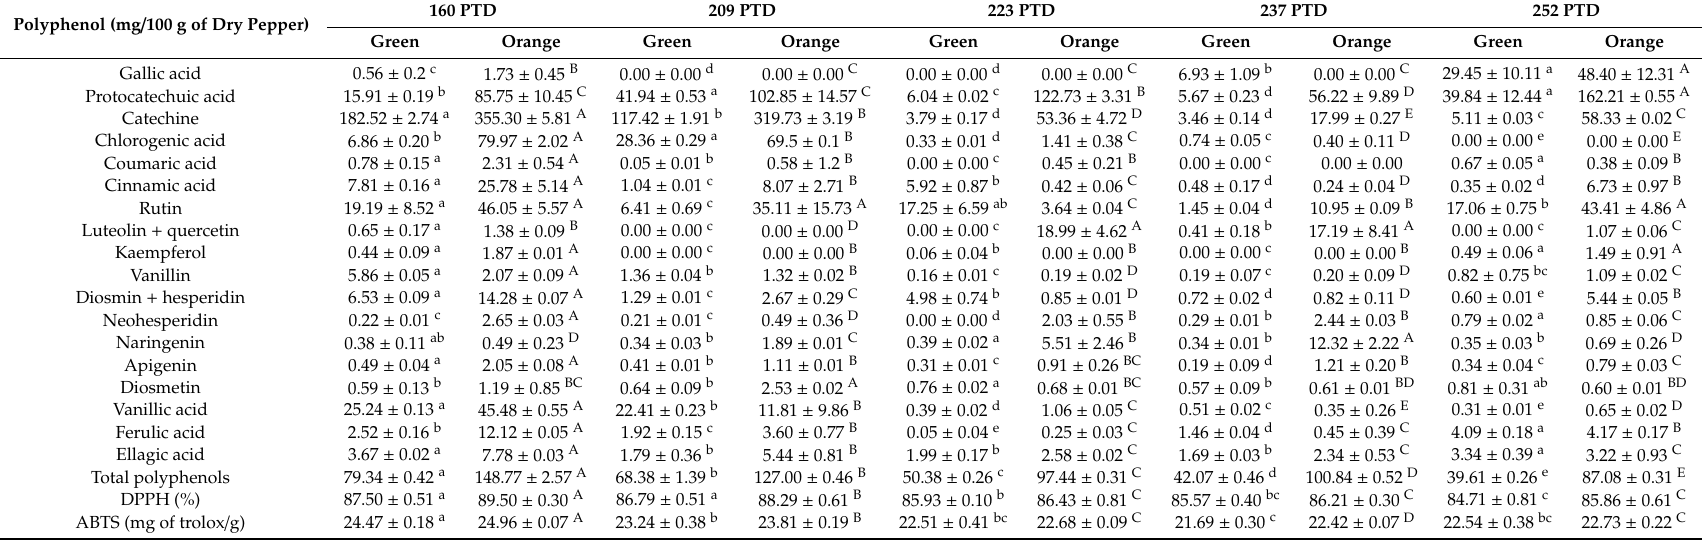
Table 1. Results of the quantification of polyphenols in mature (orange) and immature (green) Habanero pepper ( Capsicum chinense Jacq.) at di ff erent harvest times (or